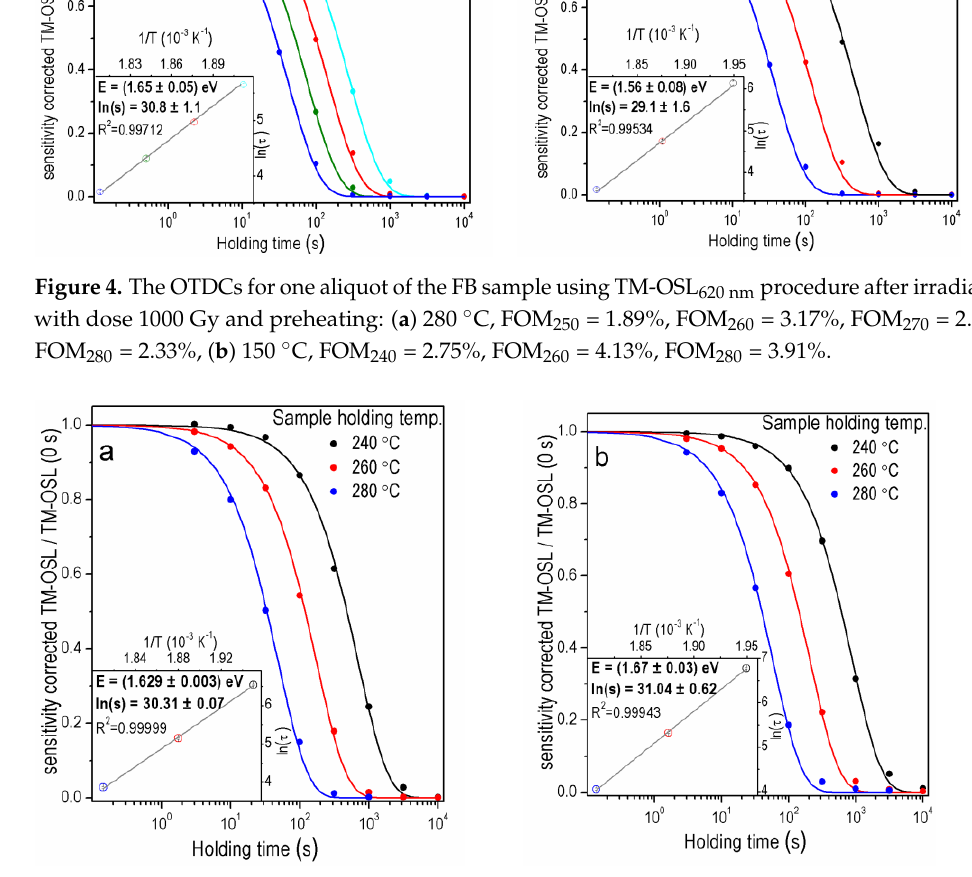
Figure 5. The OTDCs of the quartz samples ( a ) 2 MV 570A for dose 1000 Gy, FOM 240 = 1.57%, FOM 260 = 1.53%, FOM 280 = 2.99%, ( b ) MR for dose 100 Gy, FOM 240 = 1.17%, FOM 260 = 1.65%, FOM 280 = 2.98% for one aliquot and preheating 280 °C.